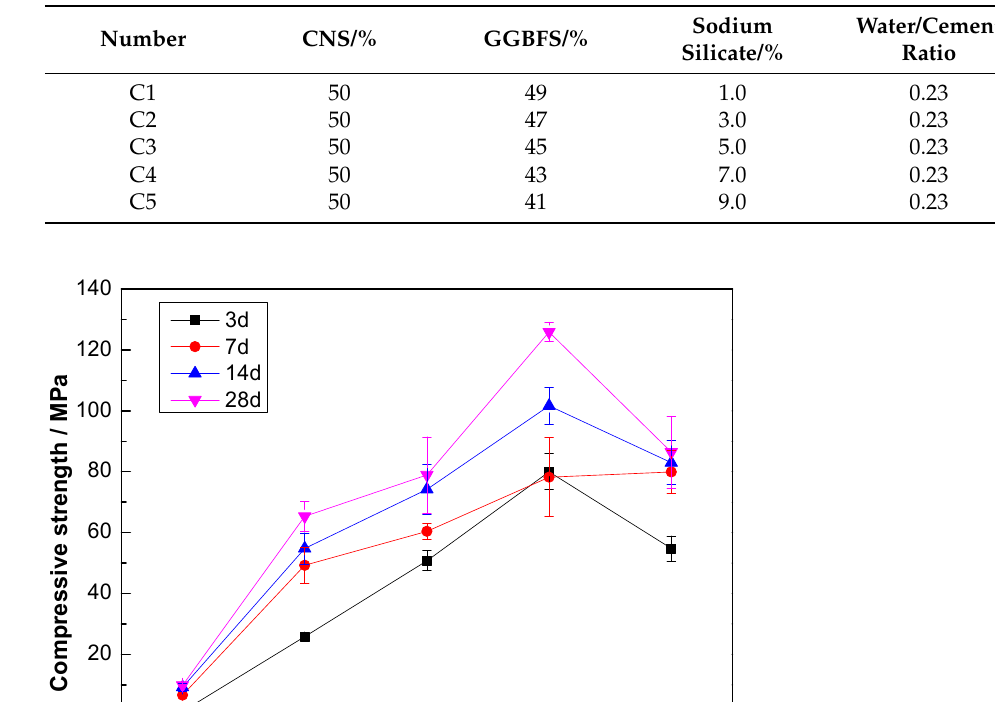
Table 3. Experimental results.